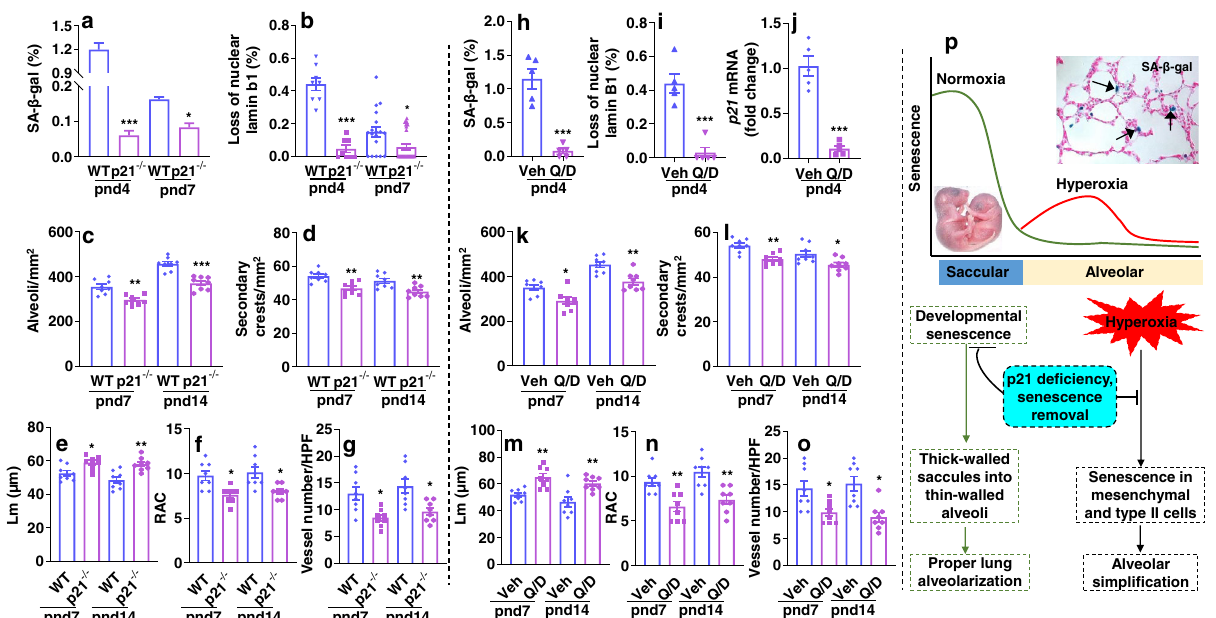
Fig. 10 | Embryonic deletion of p21 or treatment with a senolytic cocktail during the saccular stage disrupts lung development. a – f Lungs from p21 knockout mice and WT mice were collected at pnd4, pnd7 or pnd14 under nor- moxia. a , b Lung SA- β -gal activity and lamin b1 staining were performed, and cells positive for SA- β -gal or without nuclear lamin b1 were counted and normalized to total numbers of nuclei. c – f H&E staining was performed in the lung at pnd7 and pnd14 to measure number of alveoli and secondary crests, Lm and RAC. g Immuno fl uorescence of vWF was performed to detect the number of vWF posi- tive blood vessels in the lung. h – o Lungs from C57BL/6J mice were collected at